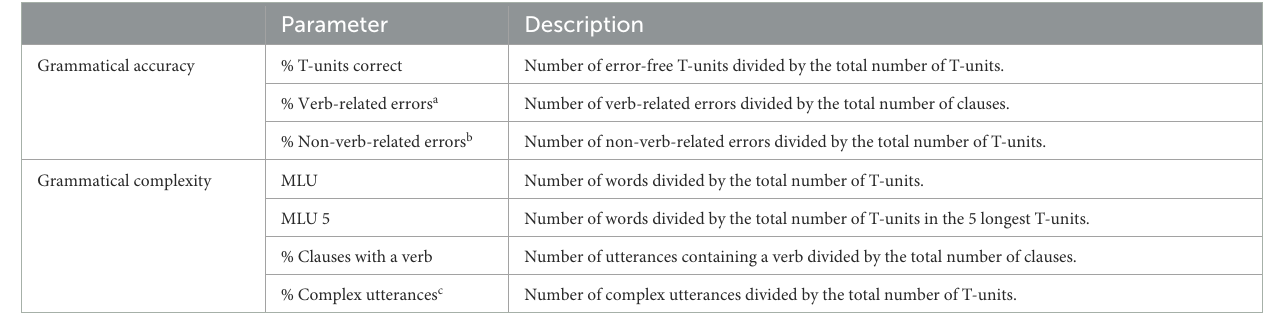
TABLE 2 Main outcome parameters of the spontaneous language